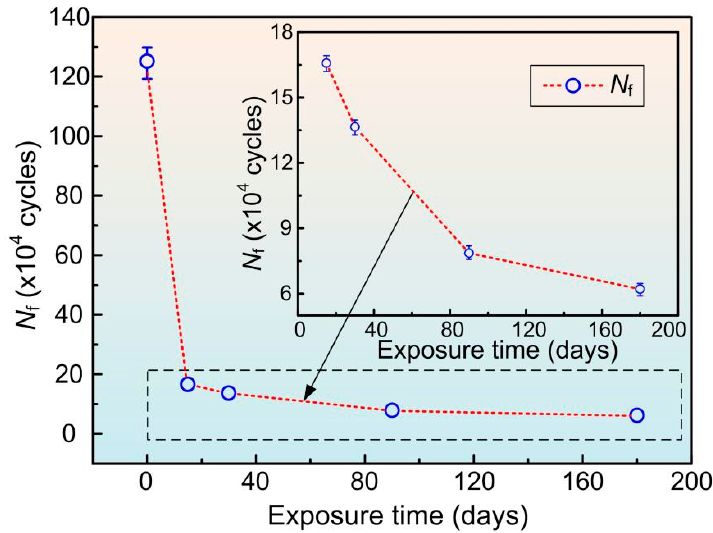
Figure 7. Average fatigue life ( N f ) of the 7075 aluminum alloy specimens subjected to outdoor ex- posure for different numbers of